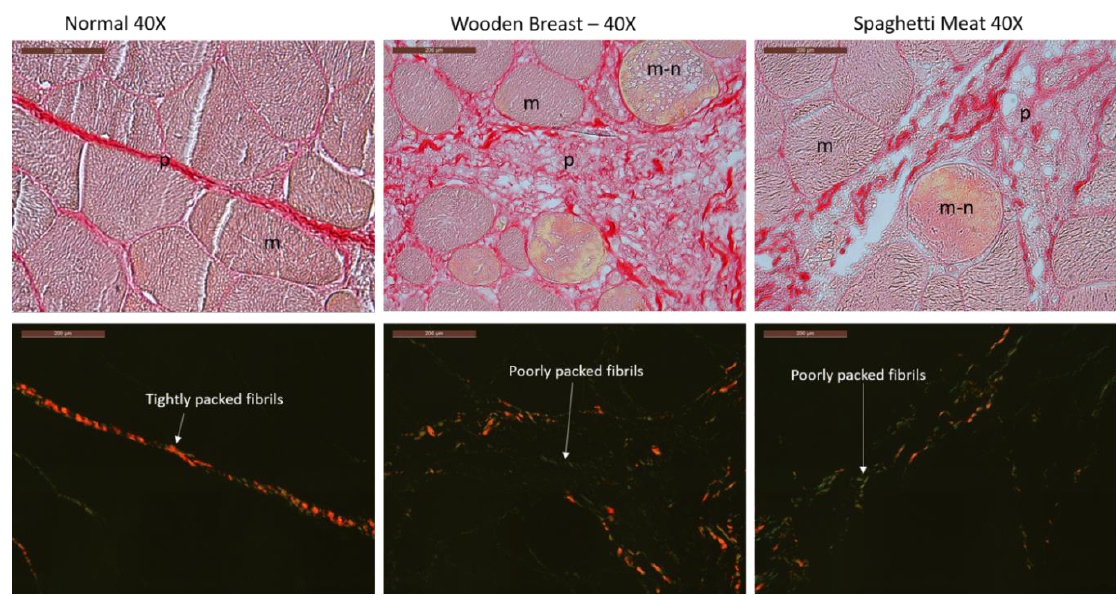
Figure 2. Picrosirius red staining: Bright-field mode (upper panel) and polarized light microscopy (lower panel). Thick collagen fibrils appear as red while thin fibrils as green. m = muscle cell, m-n = muscle cell infiltrated with macrophages and undergoes necrosis p = perimysium, e = endomysium. Scale bar: 200µm.